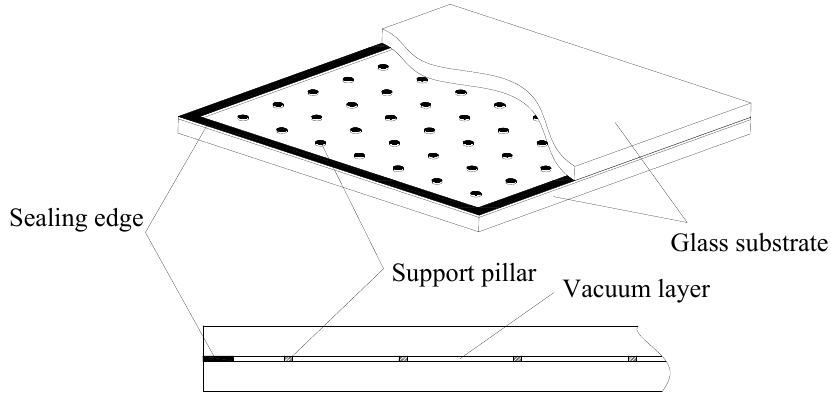
Figure 1. Structural diagram of vacuum-insulated glazing.